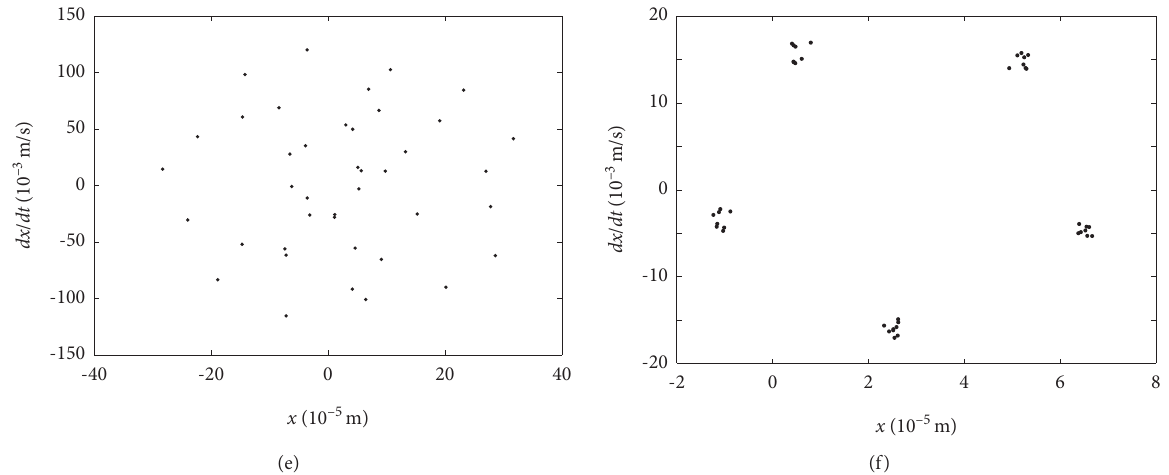
Figure 19: Poincar´e maps of disk 4 with rub-impact during hovering flight. (a) 220rad/s. (b) 226rad/s. (c) 236rad/s. (d) 252rad/s. (e) 256rad/s. (f) 270rad/s.